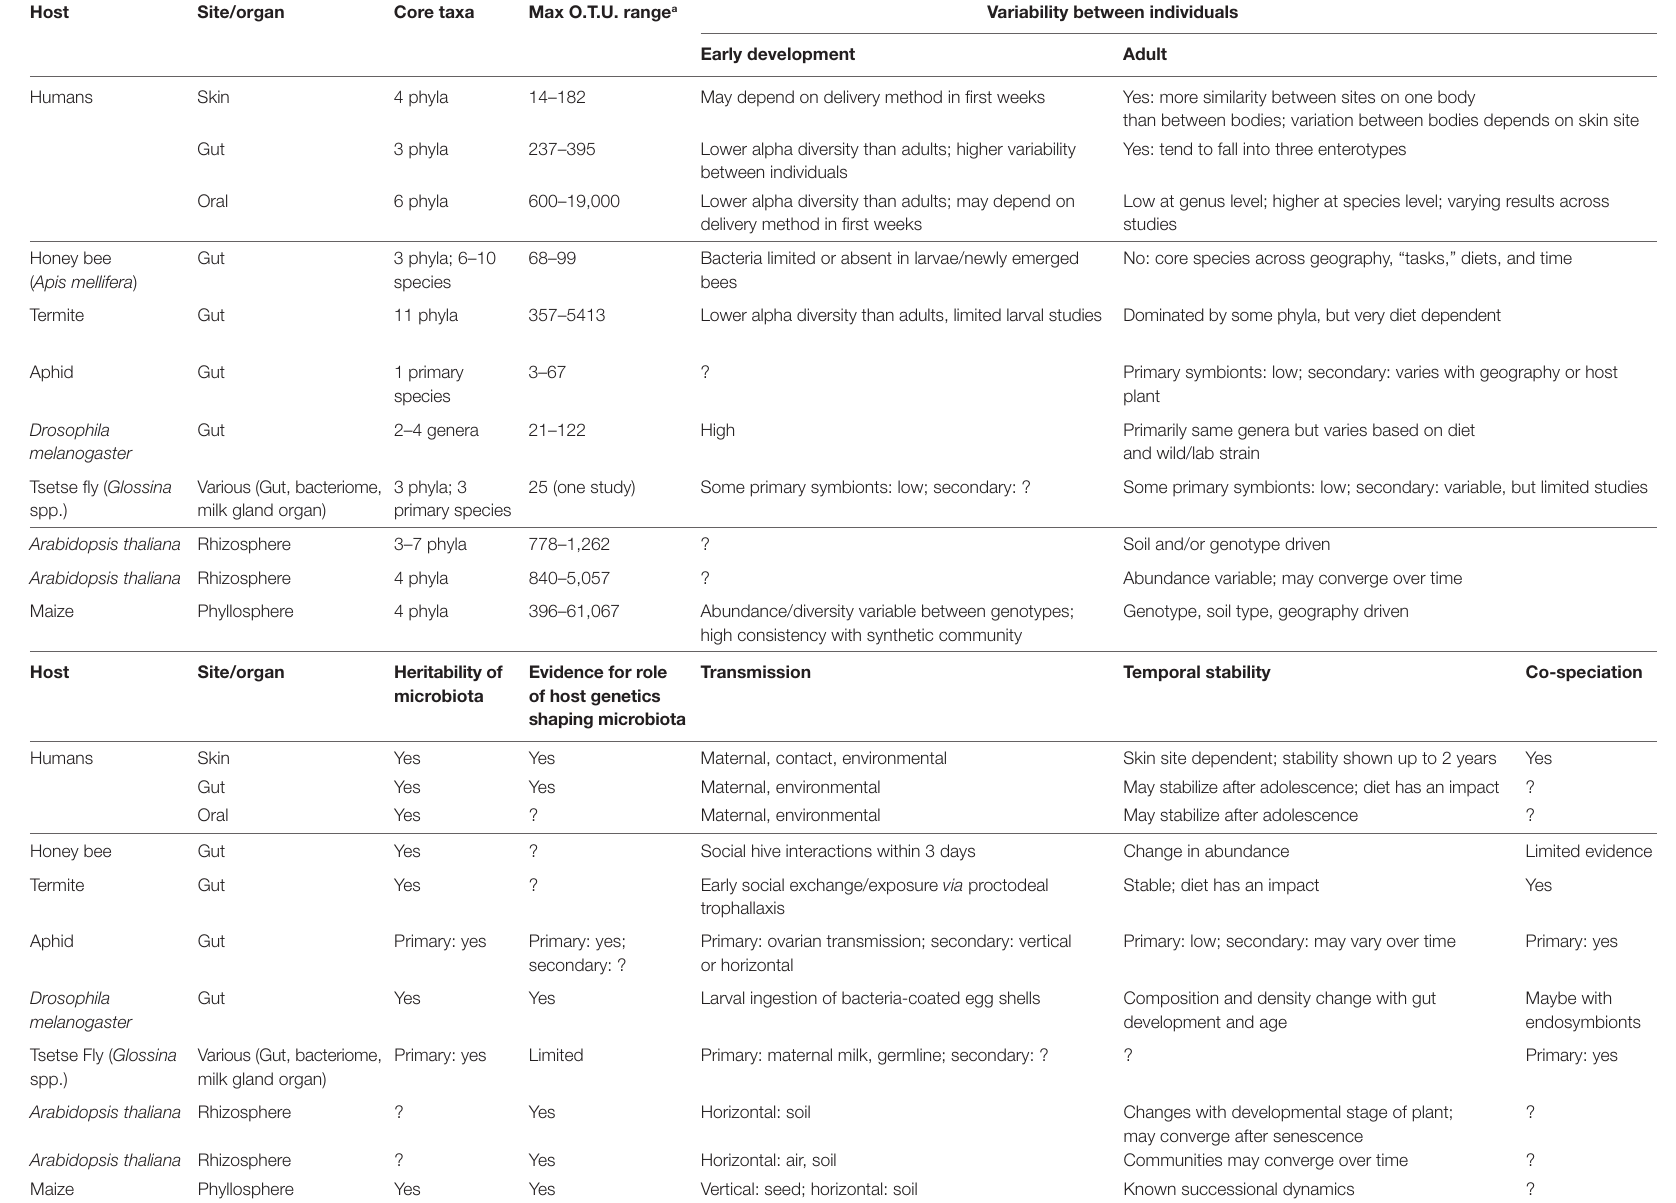
tABLe 1 | Characteristics of host/microbiota